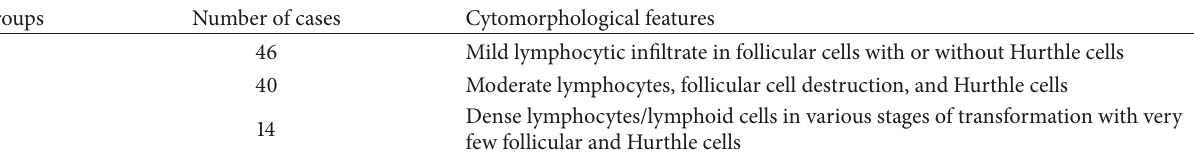
Table 3: Cytomorphological features of three groups of HT patients.